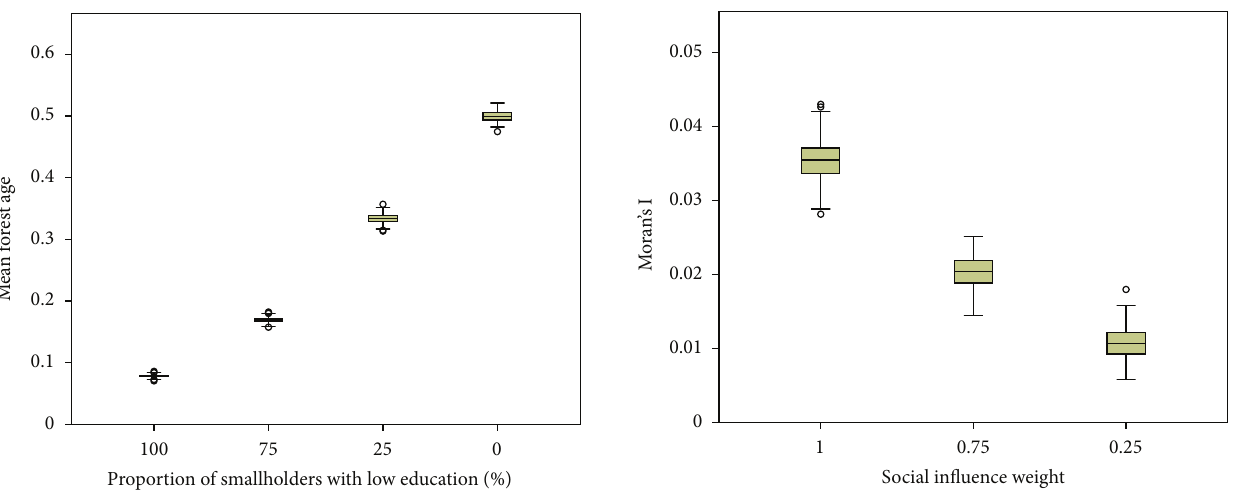
Figure 3: Mean forest age (at the landscape scale) increases significantly with a decrease in the proportion of low educated smallholders within the landscape.